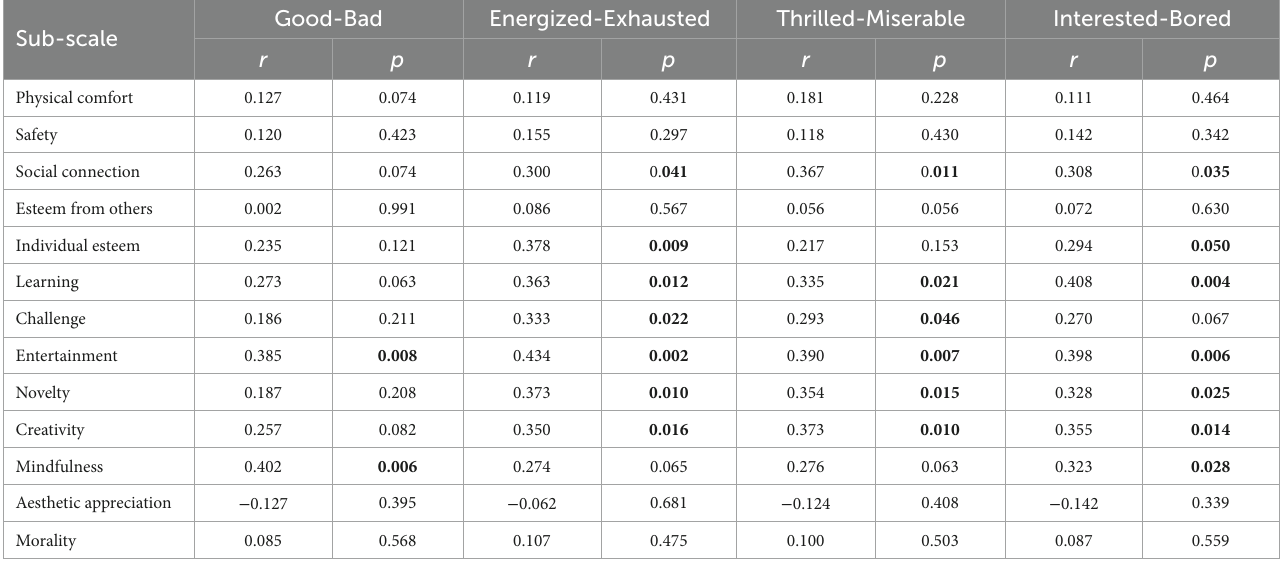
TABLE 5 Bivariate correlations of psychological needs satisfied through physical activity with affective responses during physical activity measured through ecological momentary assessment.